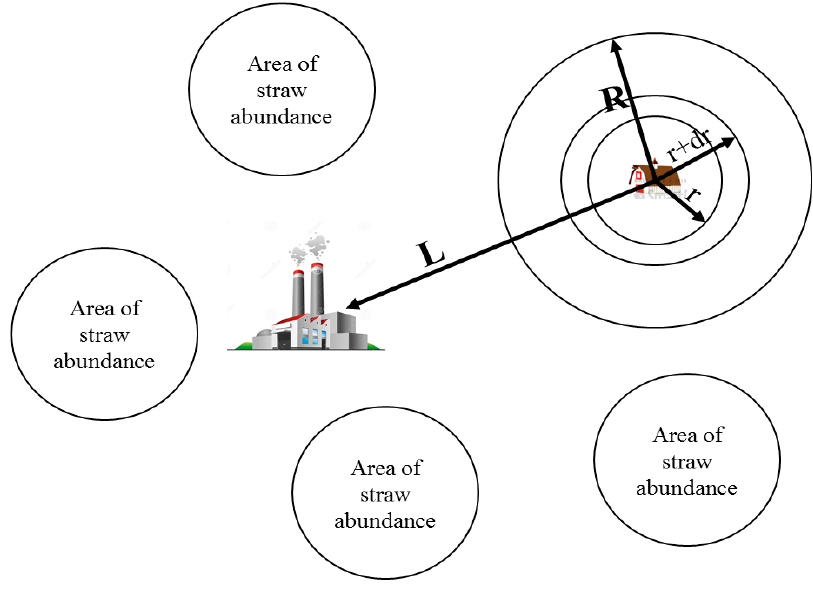
Figure 2. Assumptions regarding collection area, transportation distance, and straw supply